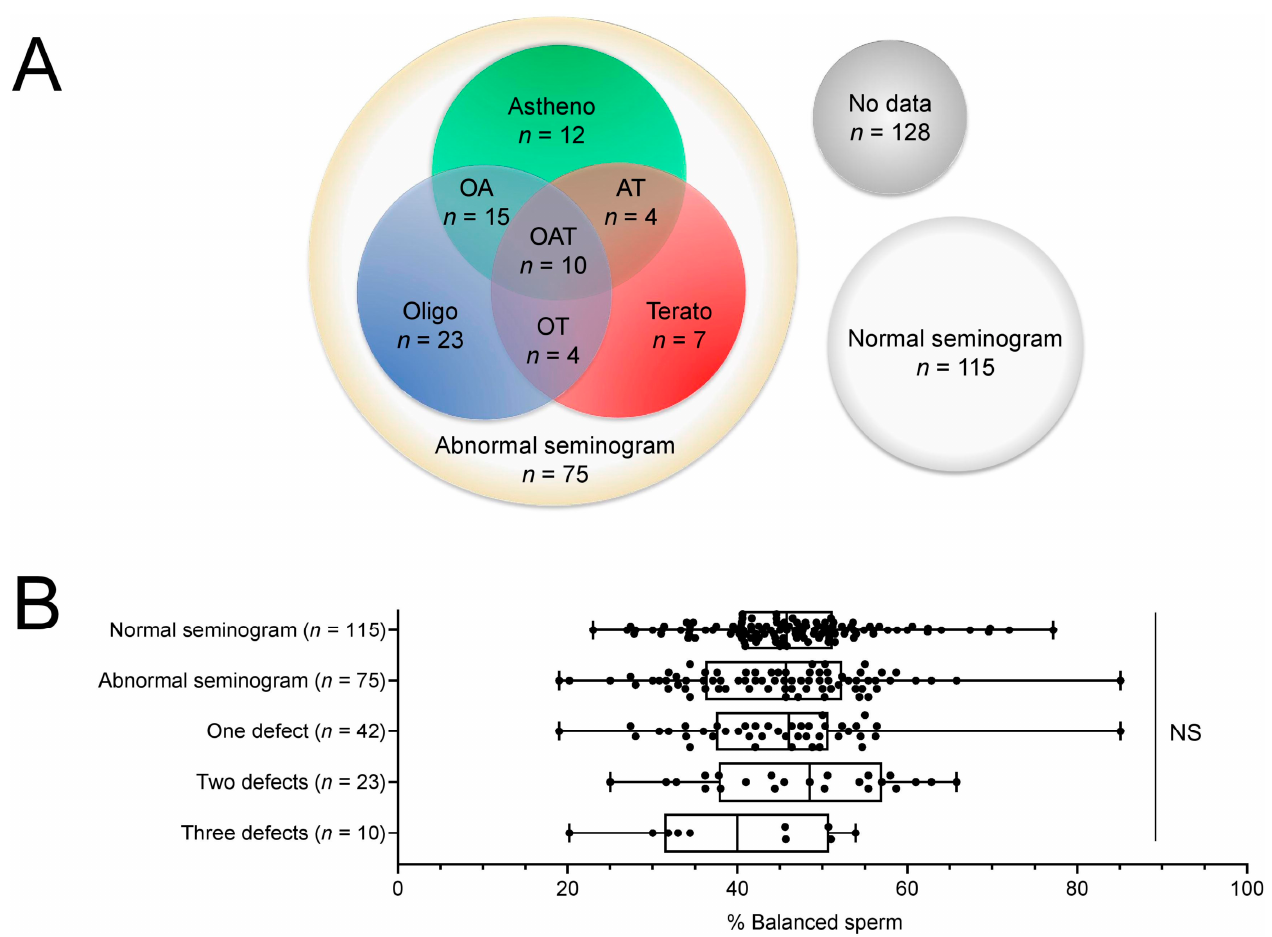
Figure 2. Relationship between balanced sperm rates and the number of sperm parameter defects. ( A ) Graphical representation of the different patient populations according to their sperm parameters. ( B ) Box-and-whisker plot of balanced sperm rates according to individual seminogram results with each data point displayed as a dot. The boxes represent the interquartile range with the median as the box centerline and 1st and 3rd quartile at the low and high box lines. The whiskers represent the minimum and maximum values. n is the number of patients, NS—not significant. Correspond- ing statistical data can be found in the Supplementary Materials Table S1.